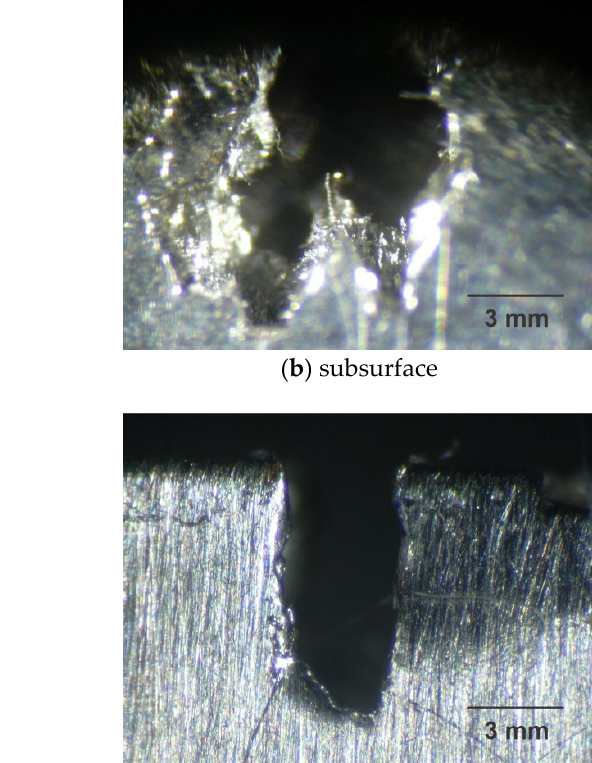
Table 7. Mean values and standard deviations of the pit density of the samples submitted to the corrosion test.